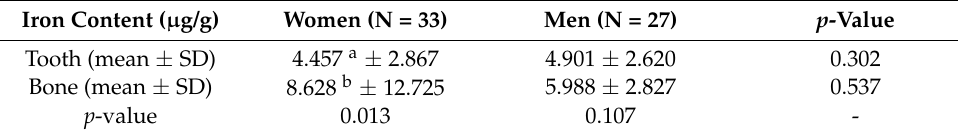
Table 19. Iron content in tested samples taken from patients of different sexes.